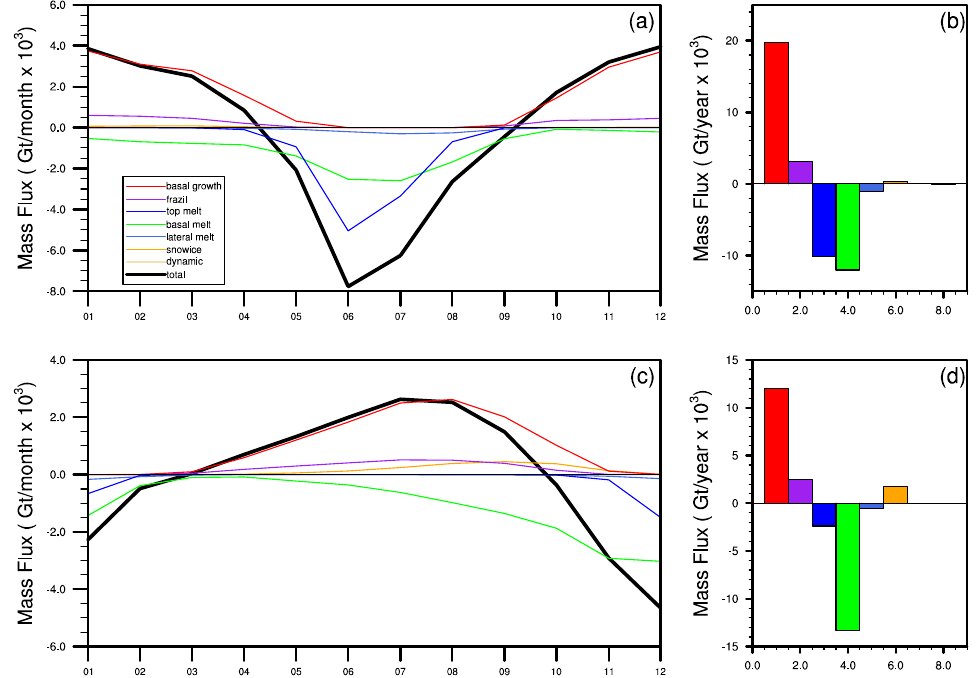
Figure 11. ( a , c ) Seasonal cycle of monthly mean value and ( b , d ) annual mean value of sea ice mass budget for Arctic ( a , b ) and Antarctic ( c , d ) regions for ensemble mean of 1979 −